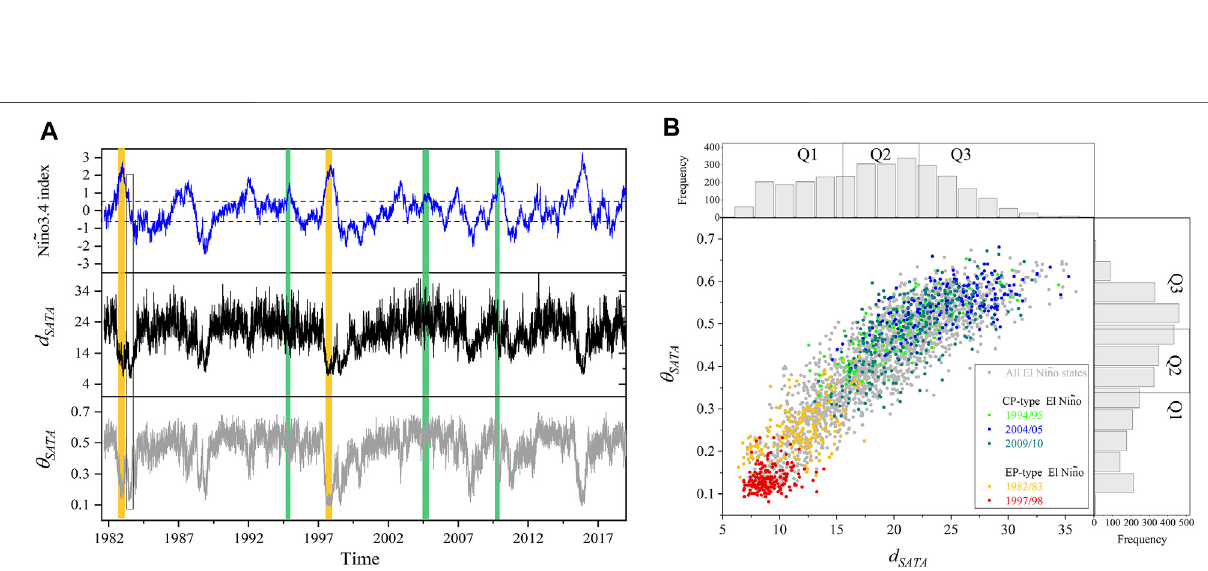
Frontiers in Physics |